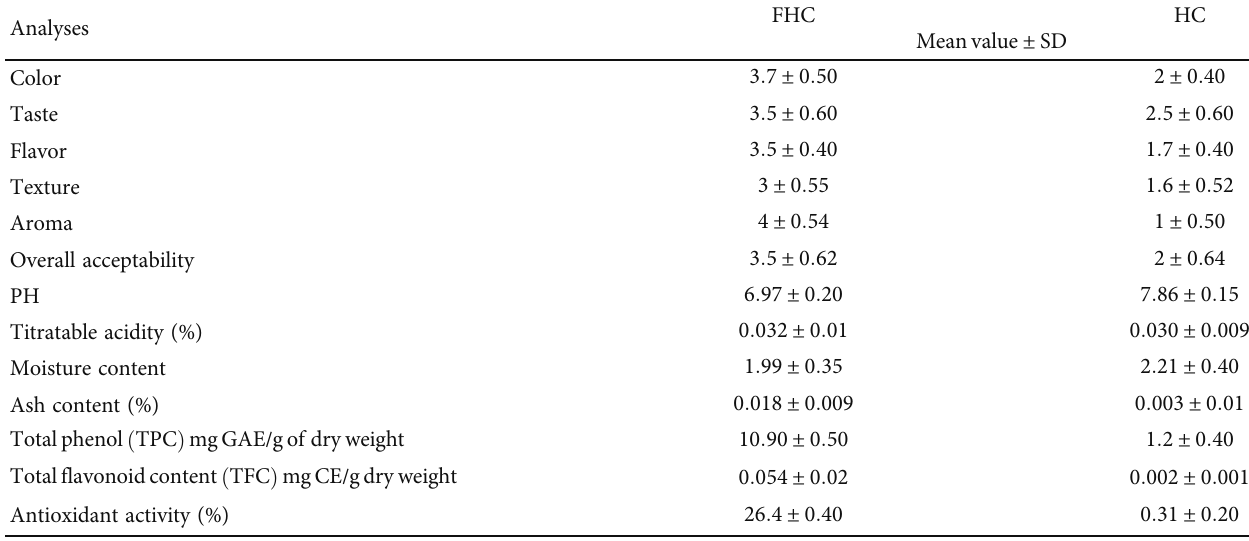
Table 5: Organoleptic, physicochemical analyses, phytochemical content, and antioxidant activity.